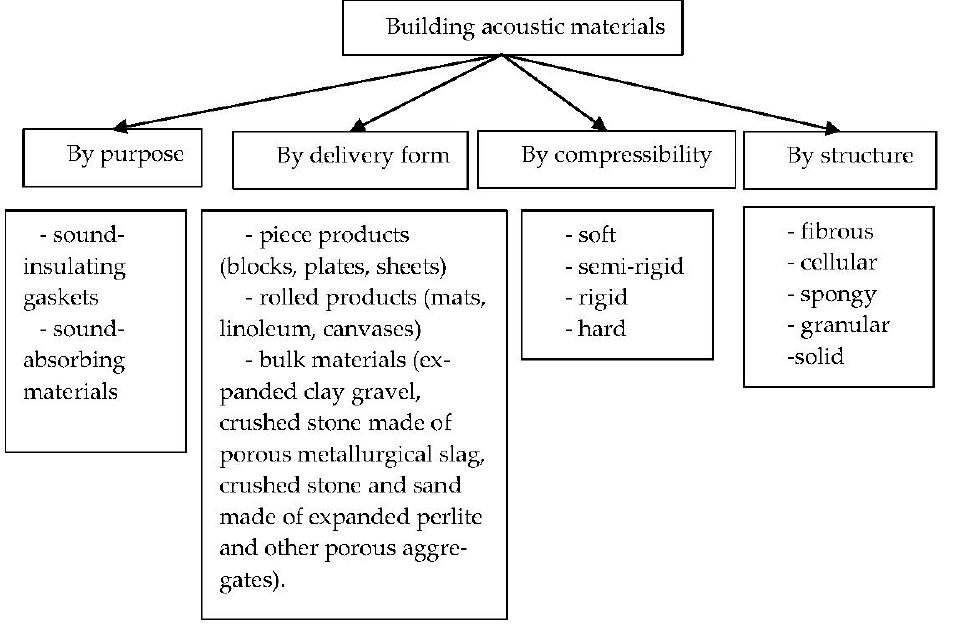
Figure 1. Classification of acoustic materials.